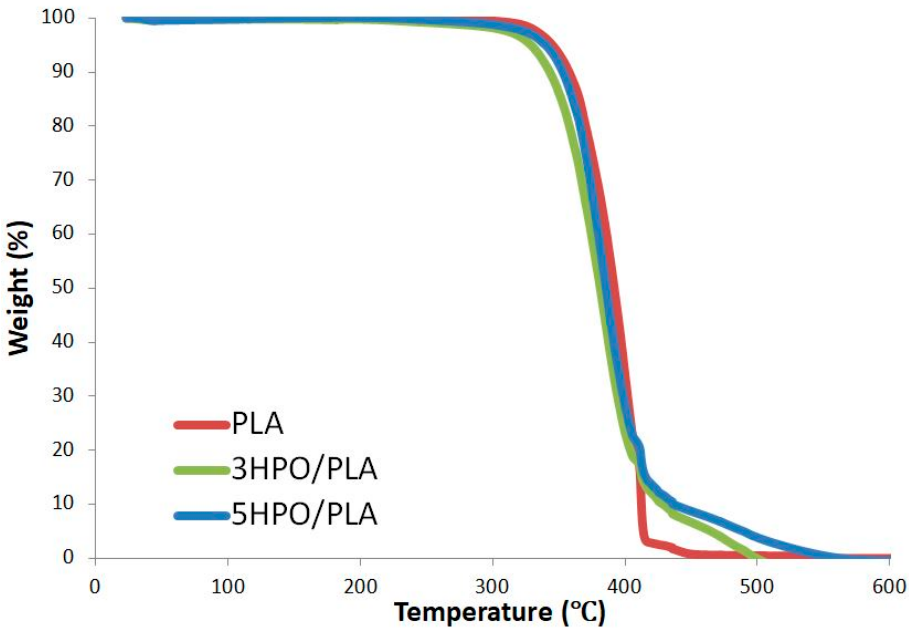
Figure 3. TGA thermograms of the PLA, and HPO-loaded PLA electrospun nonwoven fabrics.